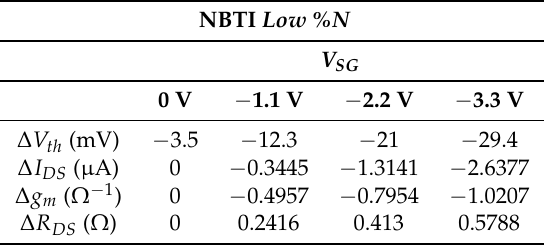
Table 3. Electric parameters; degradation for the pMOS transistor with low %N under one year of continuous operation.